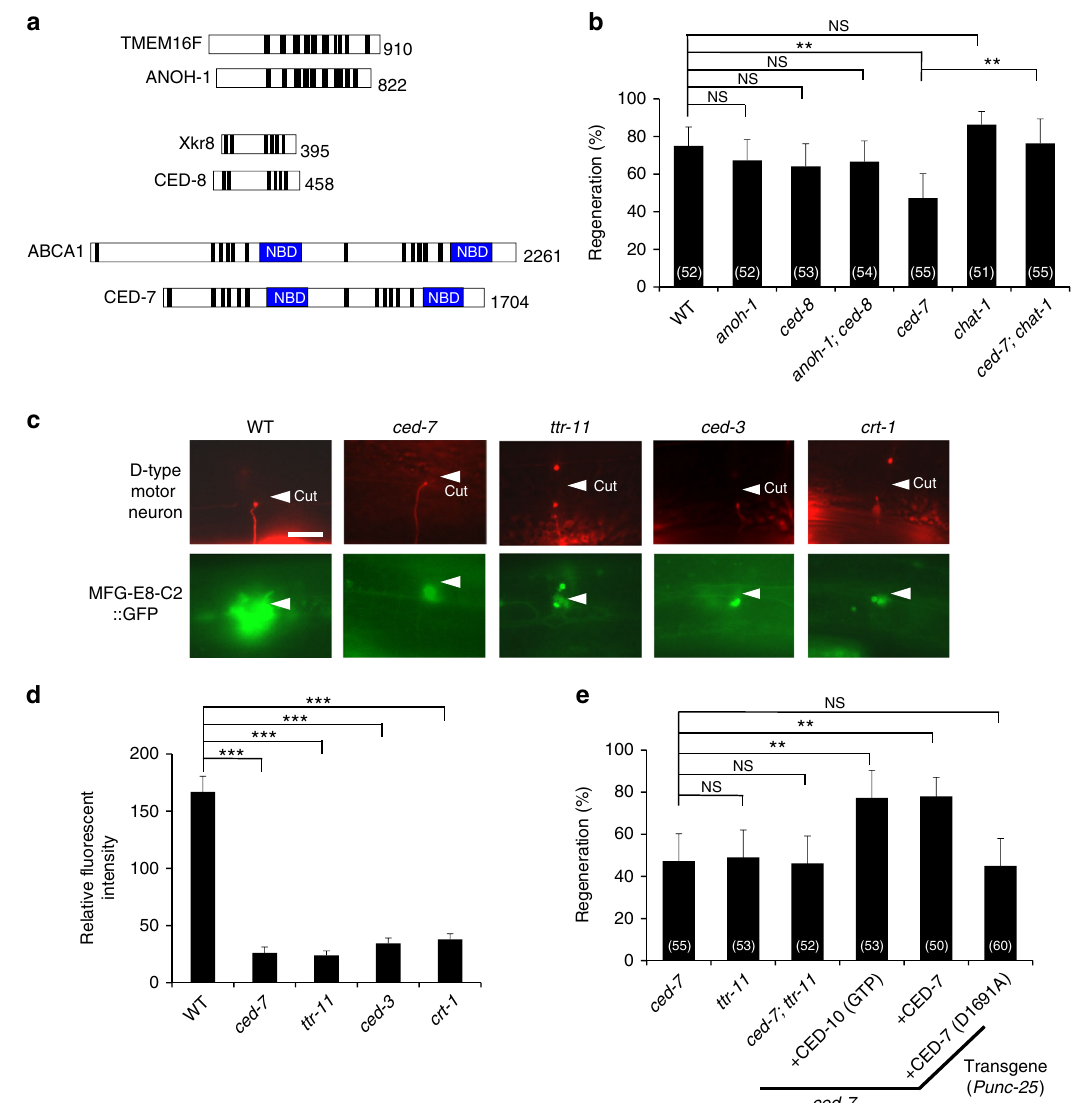
Fig. 5 CED-7 is required for ef fi cient axon regeneration. a Domain structures of C. elegans ANOH-1, CED-8, and CED-7. Schematic domain diagrams of C. elegans ANOH-1, CED-8, CED-7 and mammalian counterparts (TMEM16F, Xkr8, and ABCA1) are shown. Transmembrane domains and nucleotide-binding domains (NBD) are indicated by black and blue colors, respectively. b , e Percentages of axons that initiated regeneration 24 h after laser surgery in the L4 stage. The number ( n ) of axons examined are shown. Error bars indicate 95% CI. ** P < 0.01 as determined by Fisher ’ s exact test. NS: not signi fi cant. c Localization of MFG-E8-C2::GFP after axon injury. Fluorescent images of severed axons in animals carrying Phsp::ss::mfg-e8-c2::gfp and Punc-47::mcherry are shown. D neurons are visualized by mCherry under control of the unc-47 promoter. Each image was taken at 1 h after laser surgery. Twenty animals were examined for each condition. All 20 observations showed similar patterns. Arrowheads indicate the sites of laser surgery. Scale bars = 10 μ m. d The relative fl uorescent intensities of GFP around D neurons with laser surgery. Scores were taken at 1 h after laser surgery. Quanti fi cation of MFG-E8-C2::GFP is described in Methods. Twenty animals were examined for each condition. Error bars indicate SEM. *** P < 0.001 as determined by unpaired t